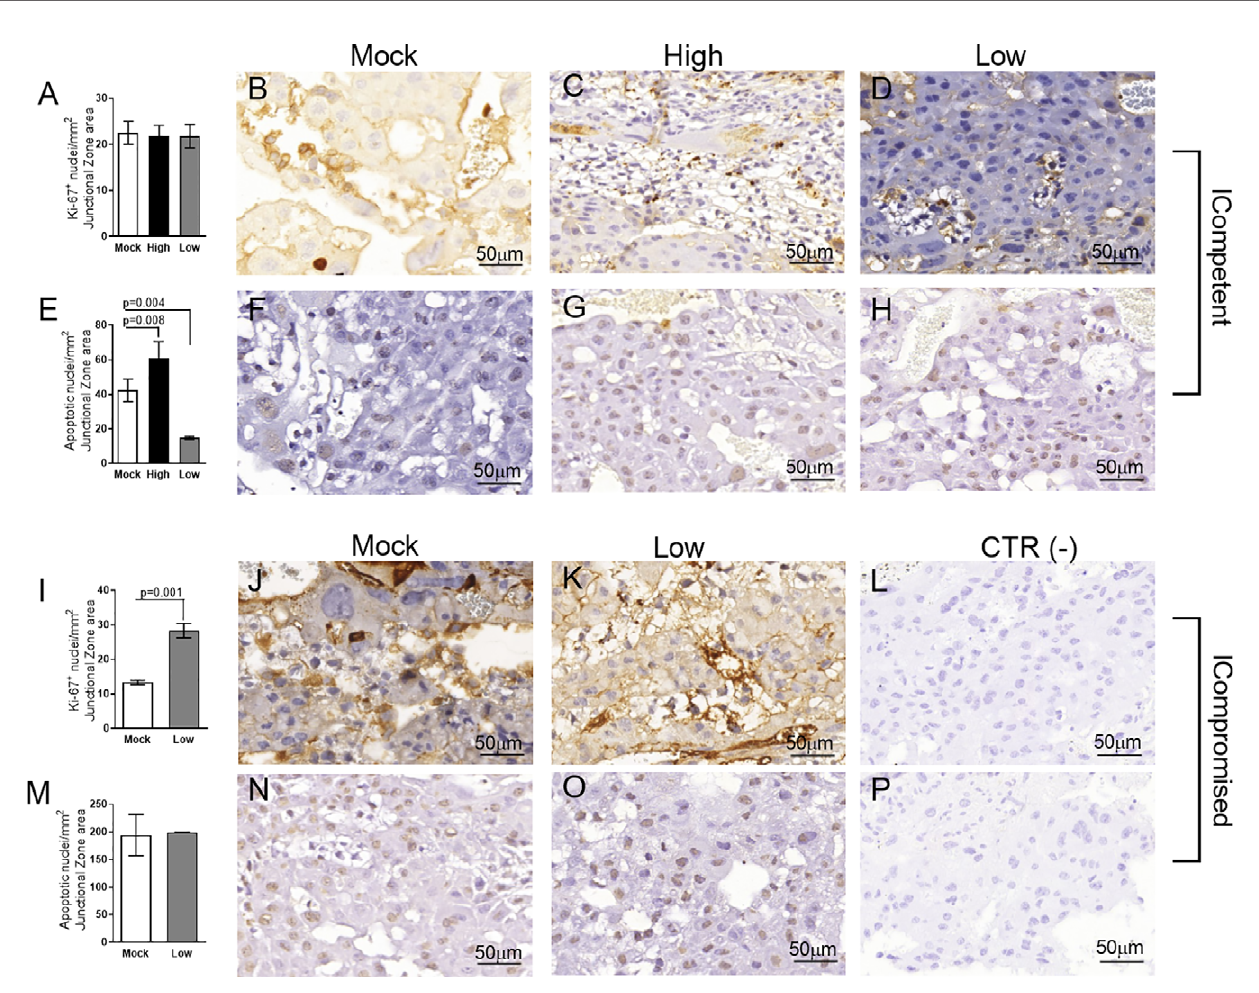
FIGURE 5 | Junctional zone remodeling in ICompetent and ICompromised placentae is affected by gestational ZIKV infection. A total of 180 digital images (40X) randomly captured from the whole junctional zone (Jz) of each placenta per dam were evaluated. Immunolabeled nuclei from each digital image were quanti fi ed and normalized by the total digital image area to obtain an index of the estimated number of proliferative and apoptotic nuclei in the entire histological section. (A, I) Quanti fi cation and (B – D, J, K) representative photomicrographs of Ki-67 + stained nuclei in the Jz of ICompetent (n=6 placentae from 6 independent dams/group) and ICompromised (n=3 placentae from 3 independent dams/group) placentae, respectively. (E, M) Quanti fi cation and (F – H, N, O) representative photomicrographs of apoptotic nuclei (TUNEL) in the Jz of ICompetent (n=5 placentae from 5 independent dams/group) and ICompromised (n=3 placentae from 3 independent dams/ group) placentae, respectively. (L, P) Negative controls. One-way ANOVA followed by Tukey ’ s posttest was used to assess changes among ICompetent groups, whereas an unpaired Student ’ s t-test or nonparametric Mann-Whitney test was used to assess differences between ICompromised groups. The values are expressed as the mean ± SEM. Images were captured at 40X. Scale bar = 50